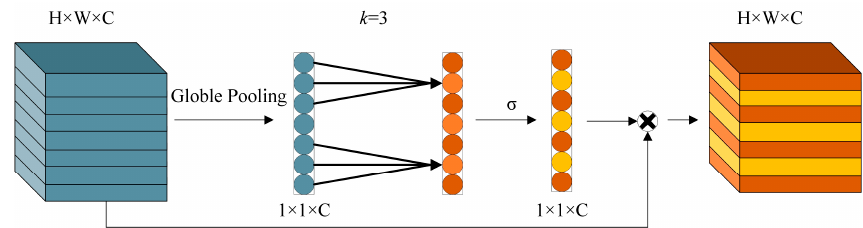
Figure 8. Structure of the ECA module.